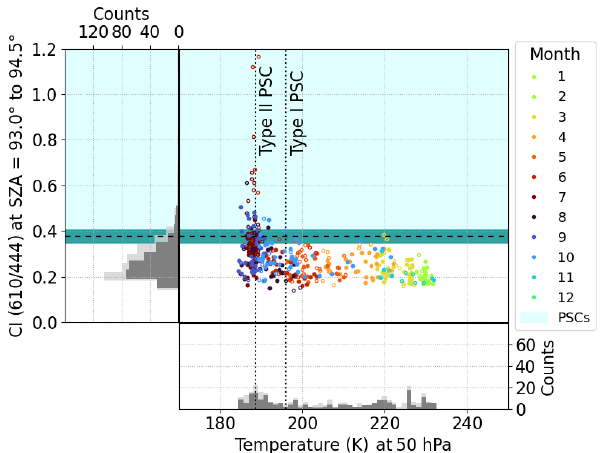
Figure 8. Colour index (CI) in the visible of the year 2007 for the Neumayer measurements. Data are represented as in Fig. 7. Note that PSC cases in the visible are characterised by an increased CI as opposed to a CI decrease in the